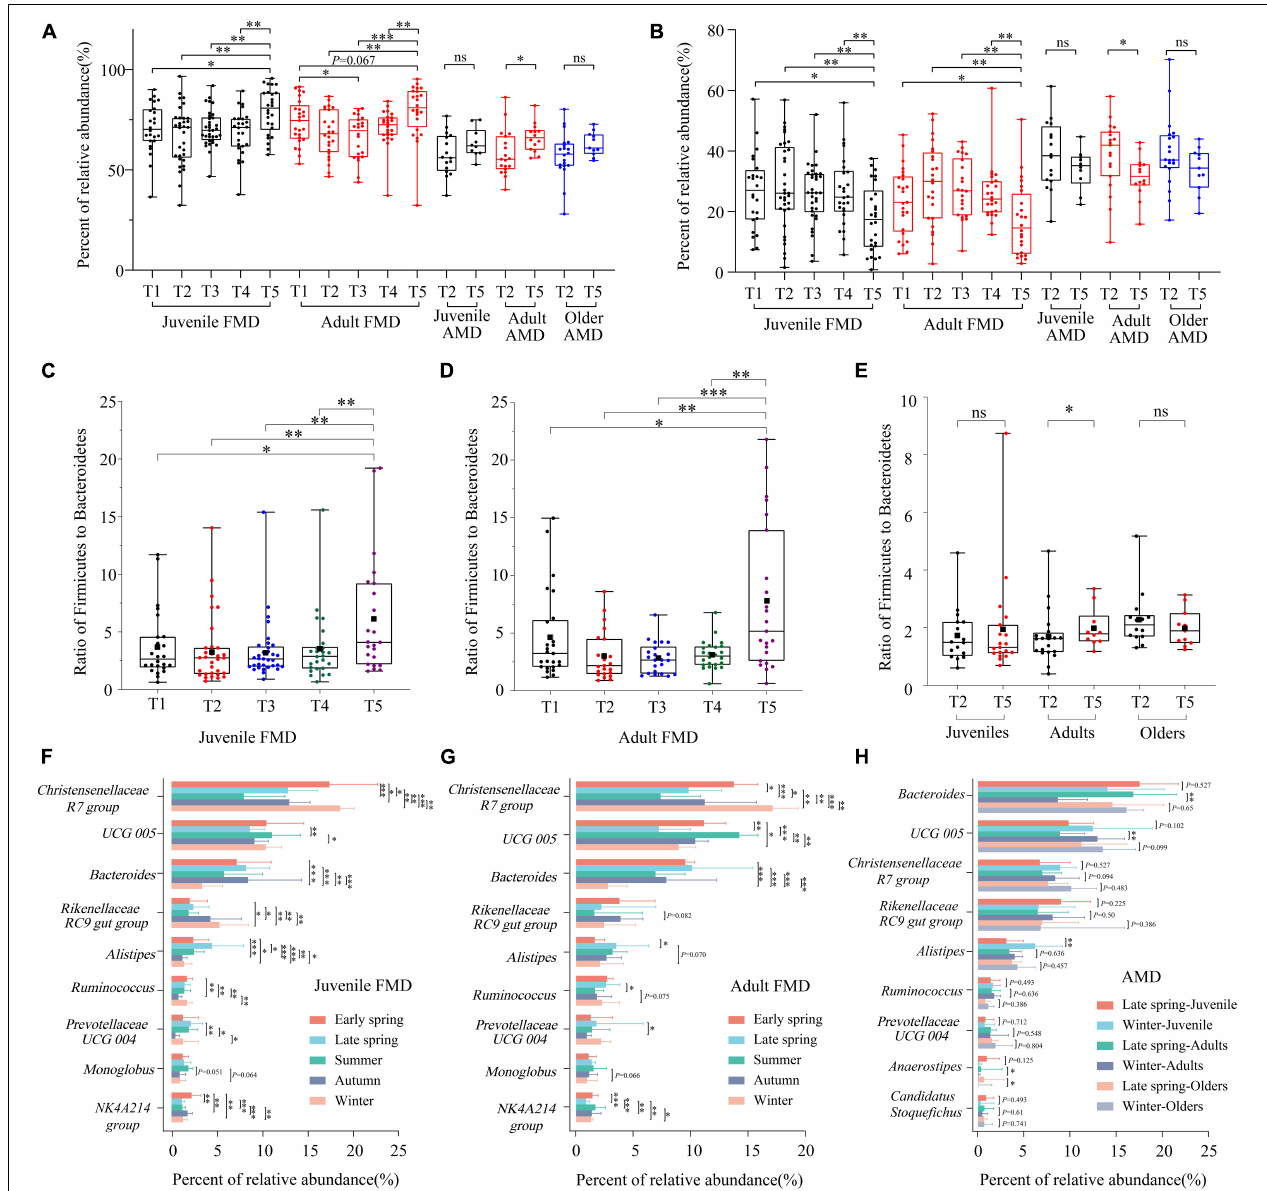
FIGURE 3 | Analysis of seasonal difference of dominant bacteria for captive FMD and AMD. Seasonal difference analysis of Firmicutes (A) and Bacteroidetes (B) for FMD and AMD. Seasonal difference analysis of the F/B ratio for juvenile FMD (C) , adult FMD (D) , and AMD at different ages (E) (excluding extreme values). Seasonal difference analysis of dominant bacteria for juvenile FMD (F) , adult FMD (G) , and AMD at different ages (H) . ∗ p < 0.05 (Wilcoxon rank-sum test), ∗∗ p < 0.01, and ∗∗∗ p < 0.001. ns, not